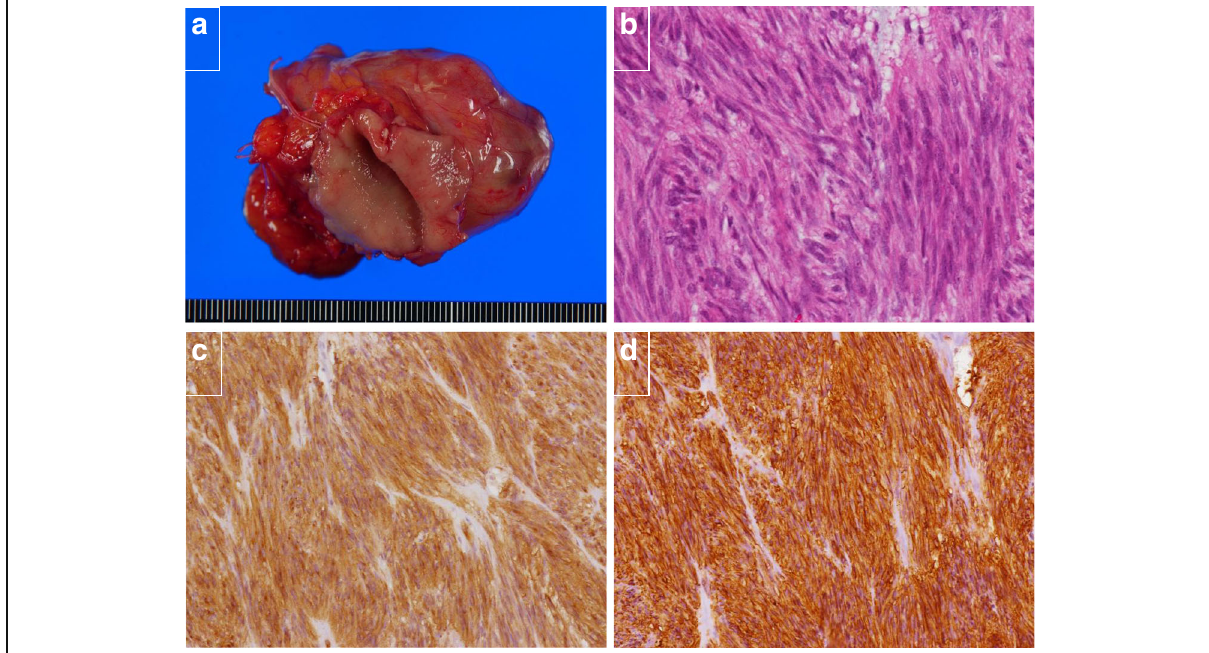
Fig. 4 a Macroscopic finding of the gastric lesion. An encapsulated solid tumor measuring 45 mm in the greatest dimension. b Microscopic finding of the gastric lesion (hematoxylin and eosin stain [HE] × 40). The gastric tumor was composed of spindle cells forming bundles in interlacing pattern. c Immunohistochemical analysis of the gastric lesion. The tumor cells showed positivity for c-KIT. d The tumor cells showed positivity for